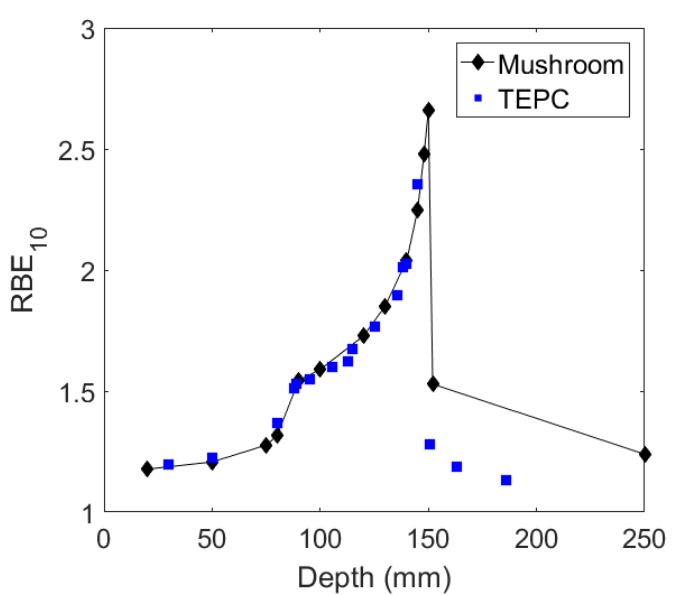
Figure 14. RBE 10 distribution obtained by the free-standing Mushroom microdosimeter embedded in Polyimide in response to 290 MeV/u SOBP 12 C ions at HIMAC in comparison with the TEPC data [33].